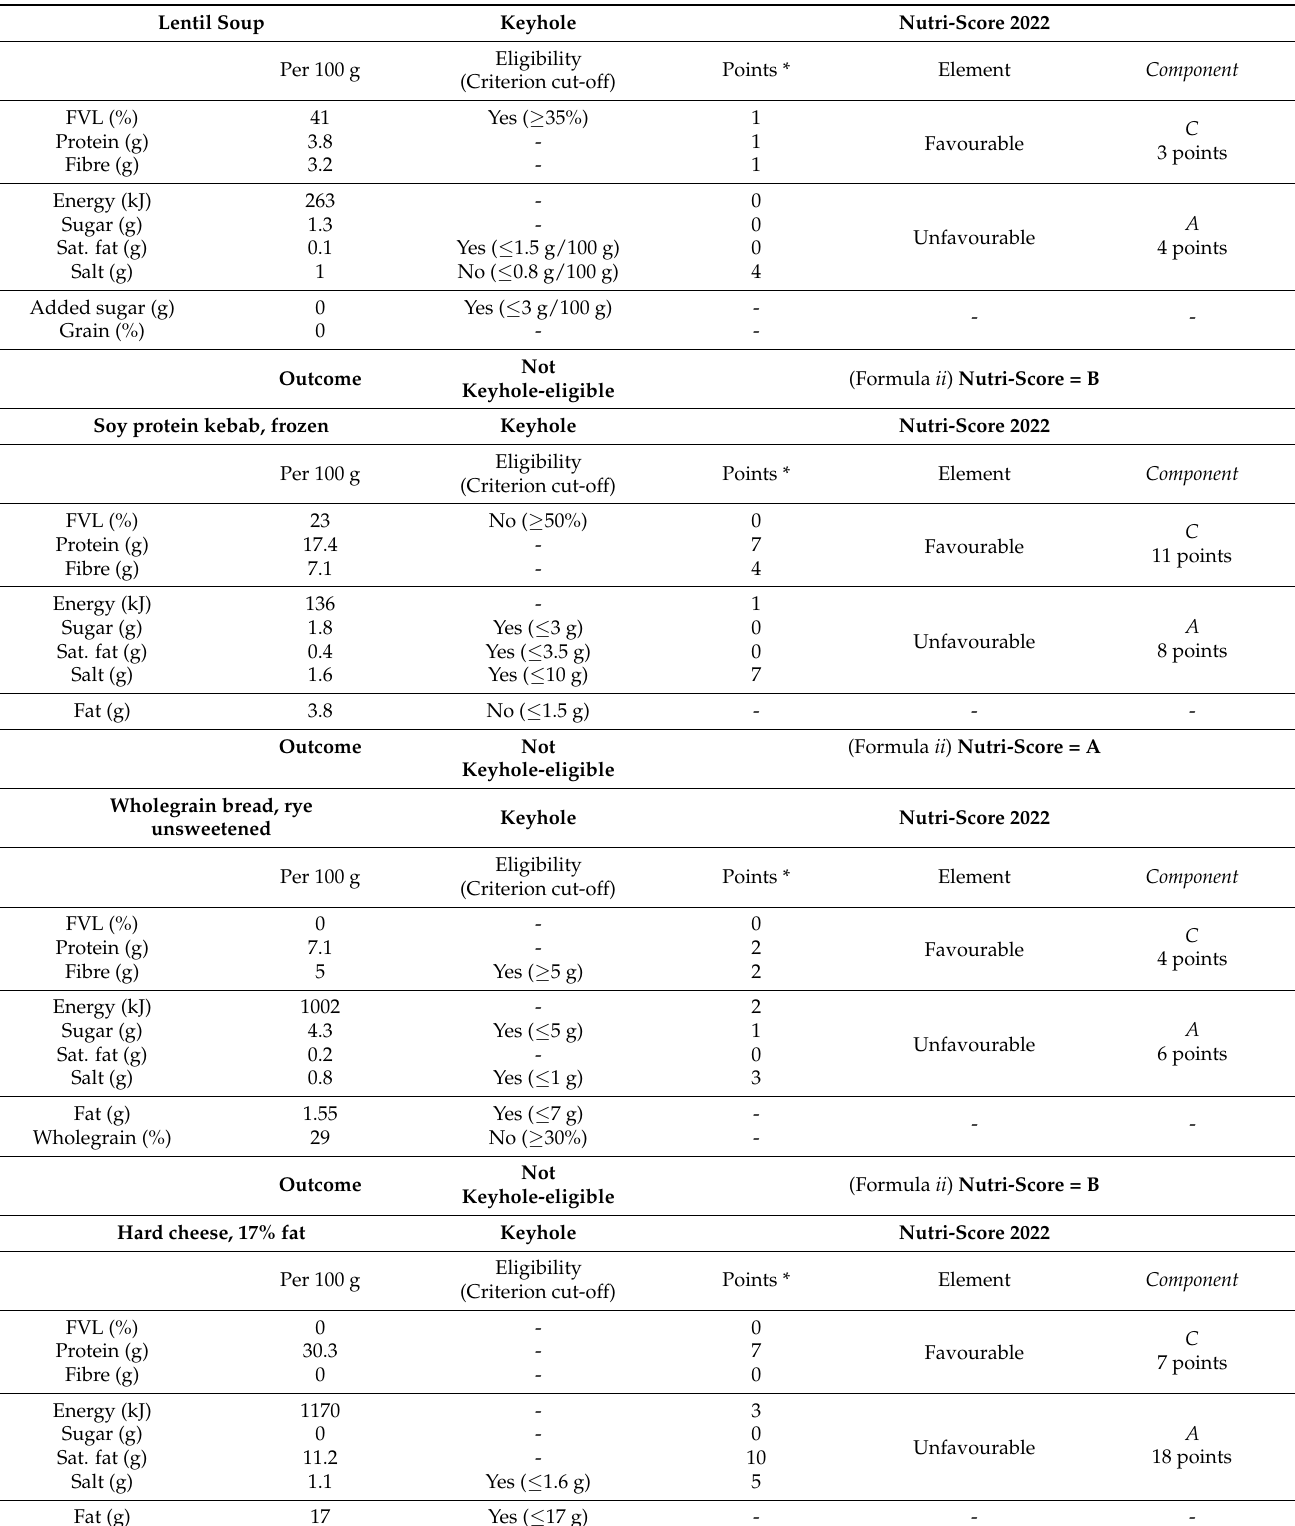
Table A2. Examples of five food items for which a disagreement between the Keyhole and Nutri-Score was